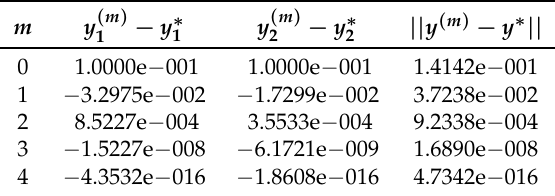
Table 2. Gauss–Newton type iterations for Example